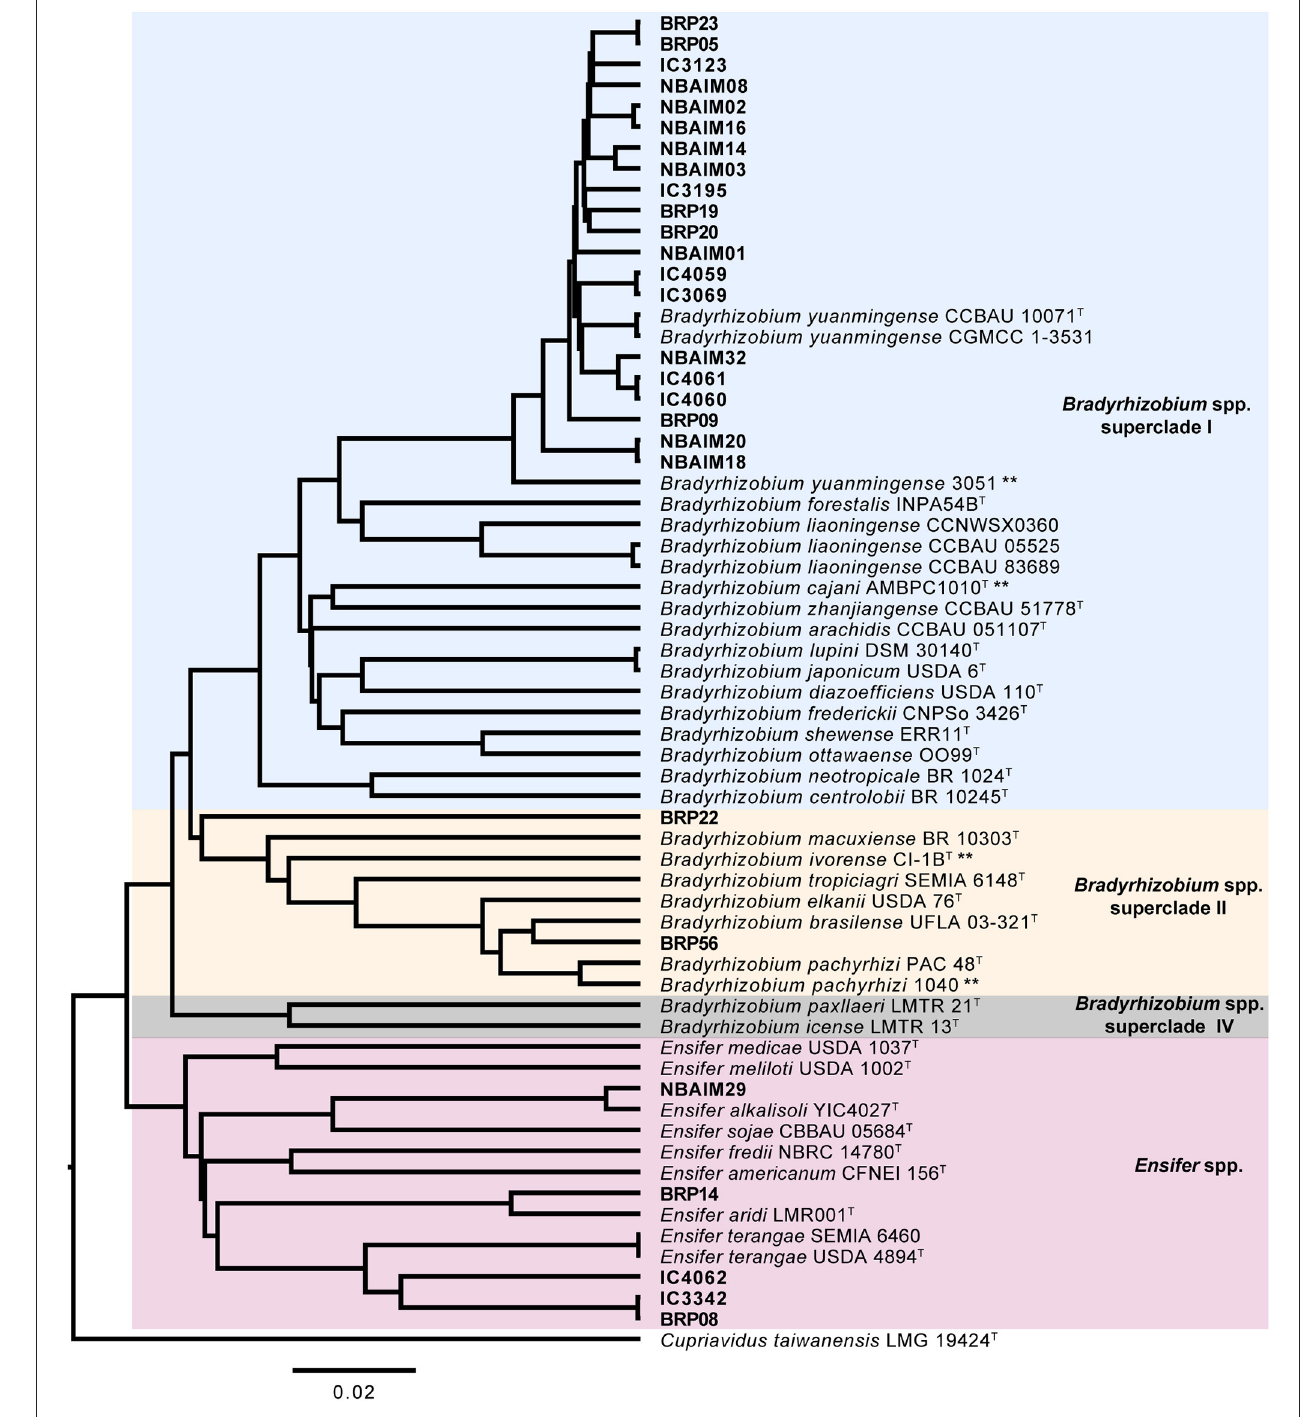
FIGURE 2 | Average nucleotide identity MUMmer (ANIm) dendrogram. ANI-based UPMGA (unweighted pair group method with arithmetic mean) tree of IU, IC, and closely related reference strains. Bar, 2 nt substitutions per 100 nt. **Strains isolated from C. cajan .